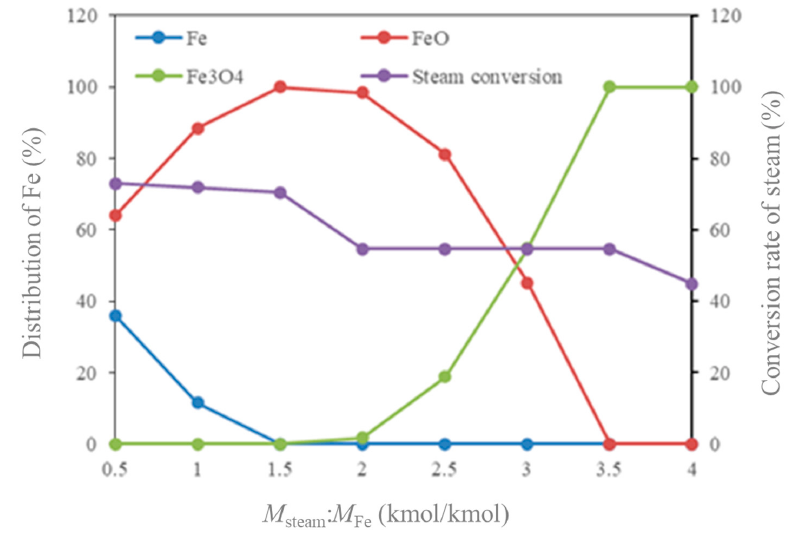
Figure 11. Influence of M steam / M Fe on iron distribution and steam conversion rate.